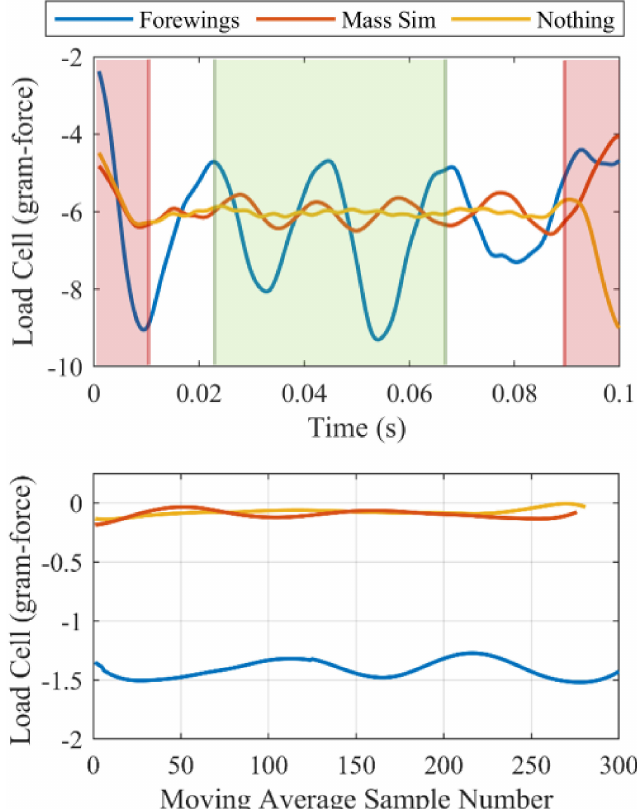
Figure 4. ( top ) Filtered data from one trial of the flapping-wing system in each of the three configurations: forewings attached (blue), mass simulators attached (red), and nothing attached (yellow). Highlighted in red are the data subjected to edge e ff ects from filtering and discarded. Highlighted in green is an example of the region of interest (one wingbeat of data) that is averaged to produce one moving average sample, shown in ( bottom